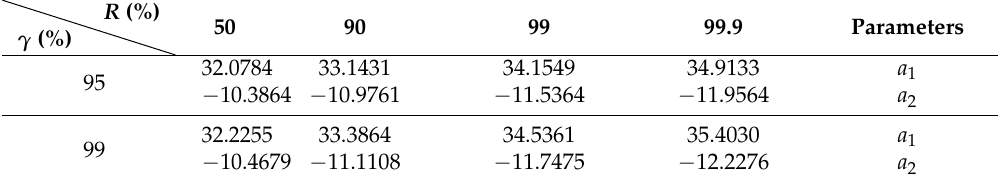
Table 8. Parameters of P–S–N at tempering temperature 600 ◦ C.